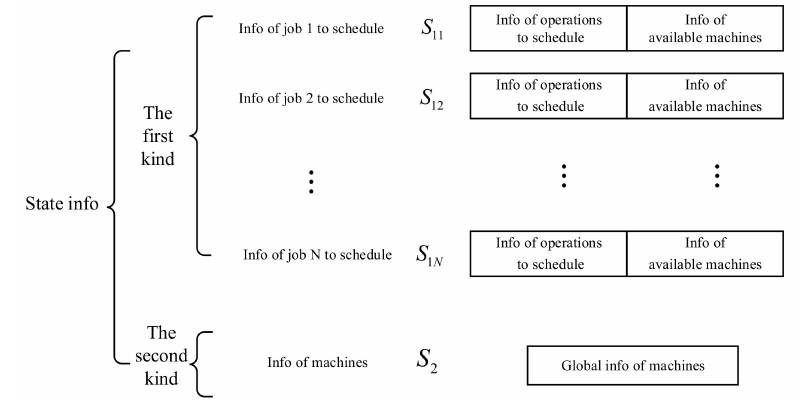
Figure 3. The information in the